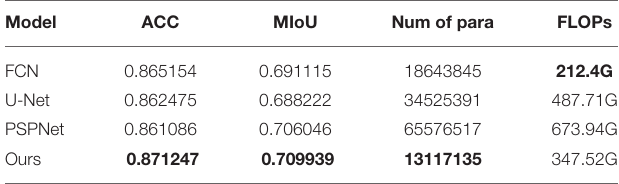
TABLE 2 | Different model performance. TABLE 3 | Model performance with different kernel